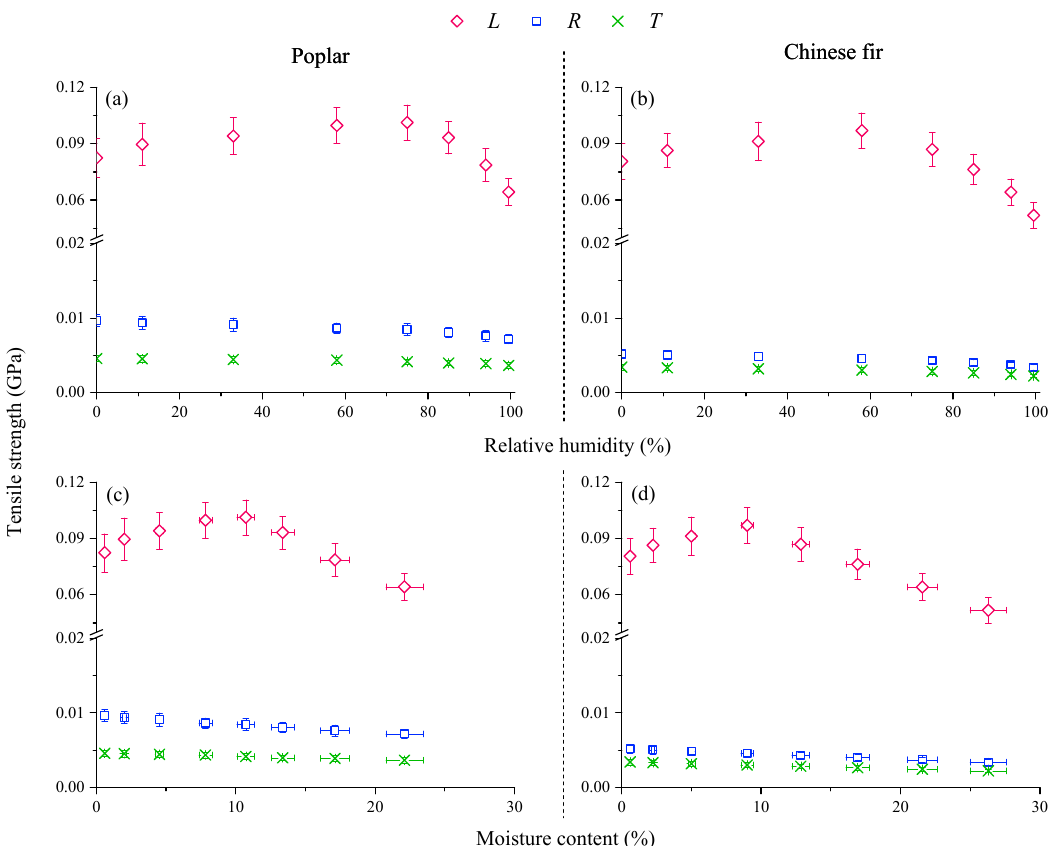
Figure 5. Influence of relative humidity on tensile strength of poplar (a) and Chinese fir (b) and moisture dependence relations (c and d).